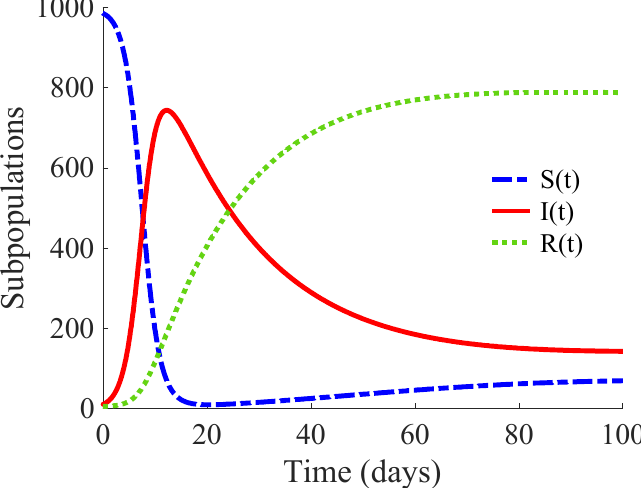
Figure 1. Time evolution of the subpopulations in the SIRS model without control actions.